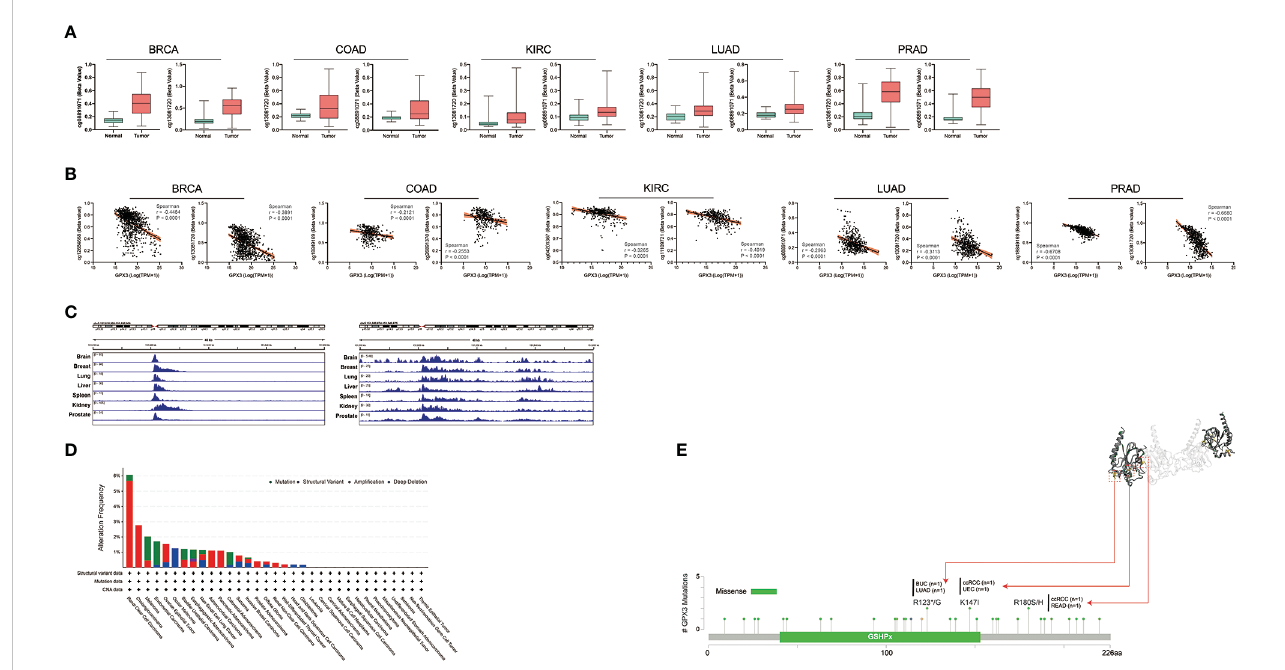
FIGURE 5 Epigenetic regulation and genetic alteration associated to the expression and structure of GPX3. (A) Based on the TCGA database, the DNA methylation level of GPX3 was analyzed in BRCA, COAD, KIRC, LUAD, and PRAD. (B) The correlation between GPX3 gene expression and DNA methylation level was analyzed in BRCA, COAD, KIRC, LUAD, and PRAD. (C) Enrichment of H3K4me3 and H3K27ac at the upstream of GPX3 in various organs. (D) The alteration frequency and mutation type of GPX3. Parts of the mutation sites were displayed within red dotted boxes in the 3D structure of